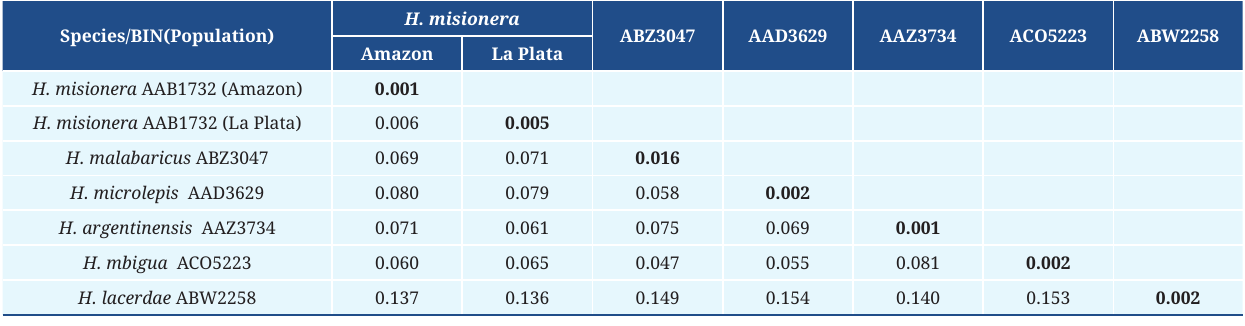
H. lacerdae ABW2258